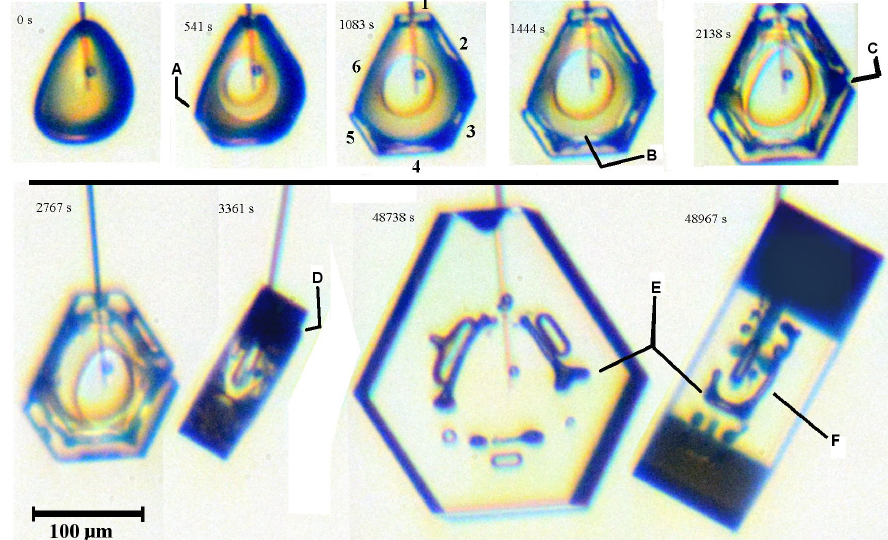
Figure 9. Elongated edge pockets and lateral face growth on a complex crystal growing under constant conditions ( − 30 ◦ C, 1% supersatu- ration). Time 0s is just after sublimation, with the crystal just starting to grow. At 541s, A marks the edge of prism face 5, growing laterally over face 6. The prism faces are filled out by 1083s and numbered clockwise from top. The B at 1444s shows a boundary with straight edge. C at 2138s shows two adjacent prism faces closing up via lateral growth (completed before 8448s, leaving an elongated edge pocket). At 3361s, D marks an interior edge of a thick layer on the bottom basal face. E marks two views of an elongated edge pocket between prism faces (same as that tracked by C). F is an elongated edge pocket between the bottom basal face and prism face